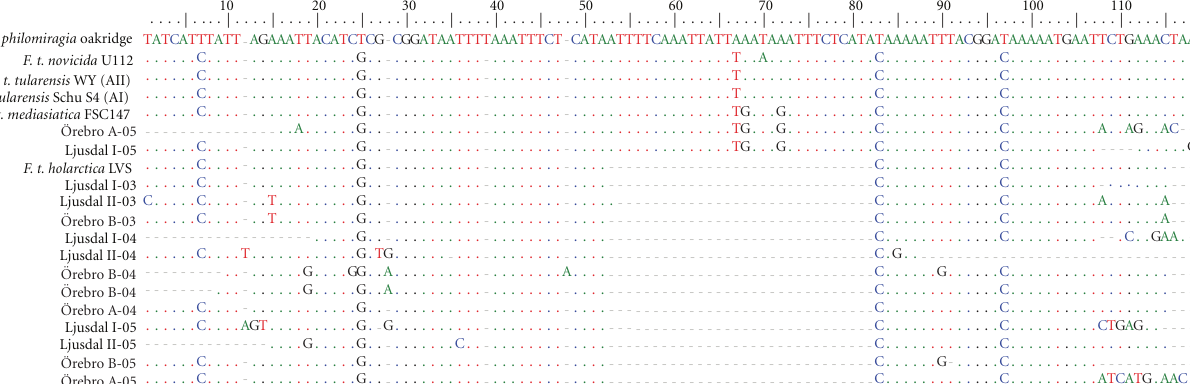
Figure 5: Multiple alignment of FtM19InDel sequences from Ljusdal and ¨Orebro with previously published sequences of Francisella species and subspecies. In this alignment the F. tularensis subsp. holarctica specific deletion is located from position 52 to 82. Reference sequences from GenBank: F. t. holarctica LVS (M32059), F. t. tularensis strain WY96-3418 (CP000608), F. t. tularensis strain Schu S4 (NC 006570), F. t. mediasiatica strain FSC147 (NC 010677), F. t. novicida strain U112 (CP000439) and F. philomiragia